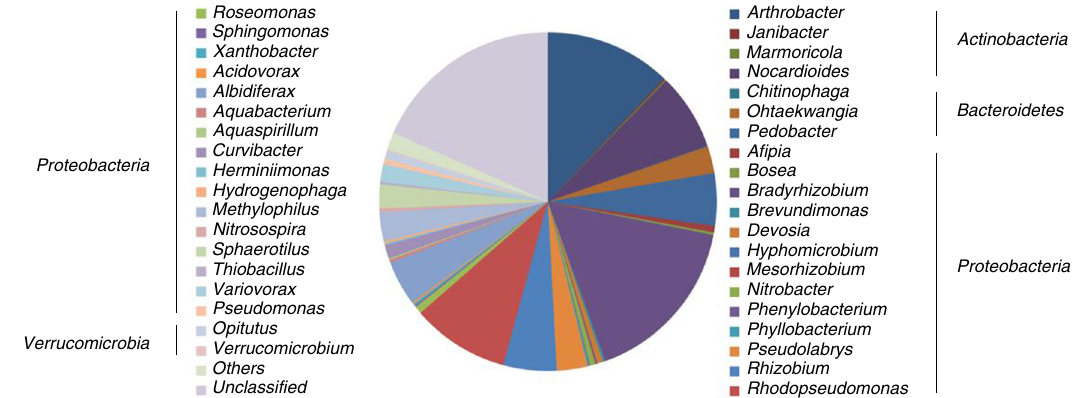
Fig. 9 The composition of bacterial communities at genetic level. The genera contained < 0.1% of sequence reads were summarized in group “ others